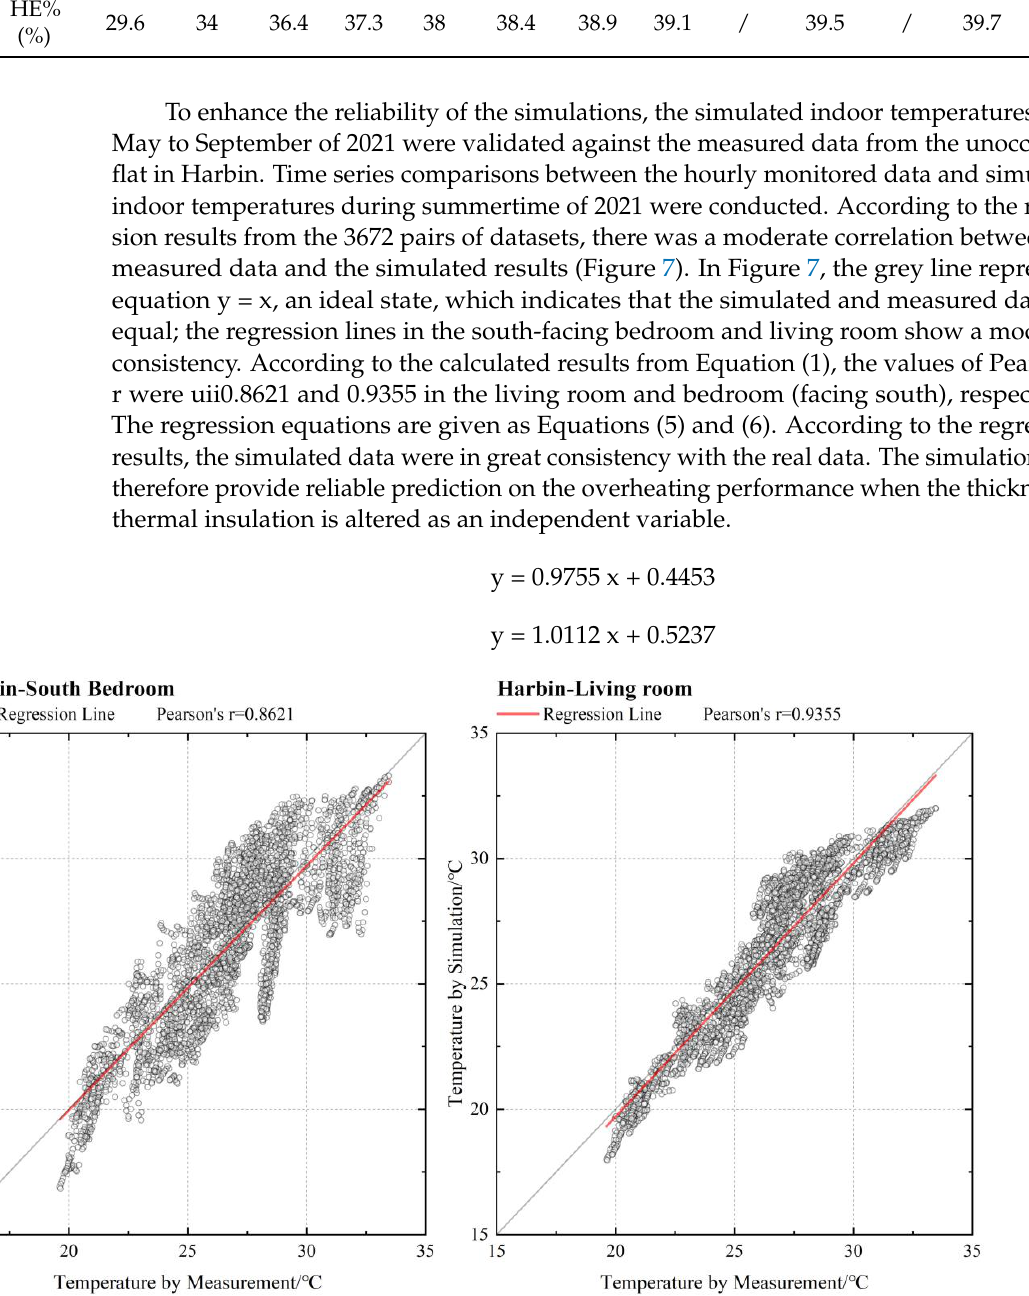
Table 10. Overheating duration with Th insulation as variable in the simulated flats (on the 7th floor) of Harbin from May to September of 2021.